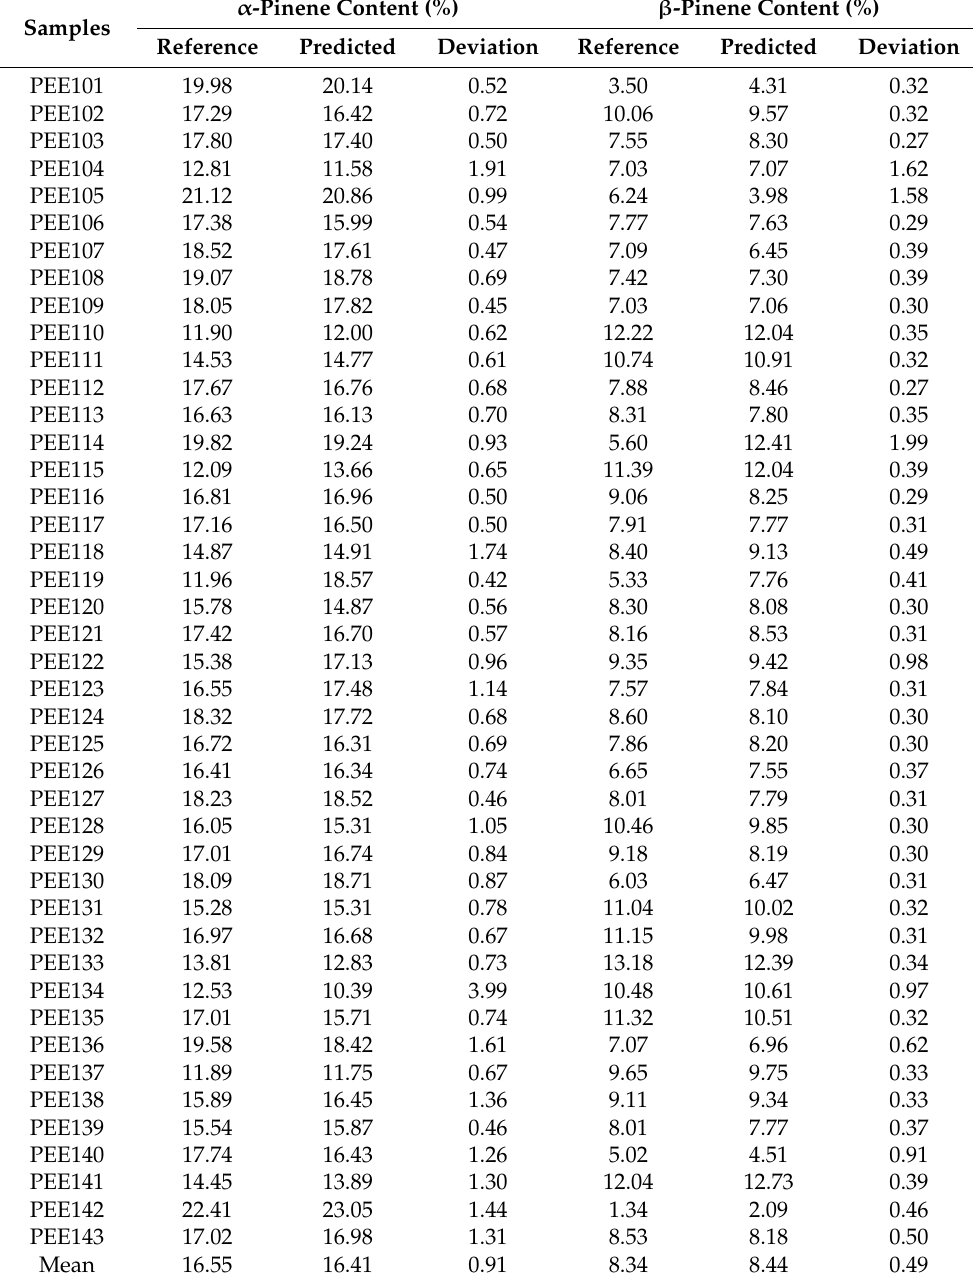
Table 3. The α - and β -pinene content of the separate validation samples predicted by the correspond- ing PLS